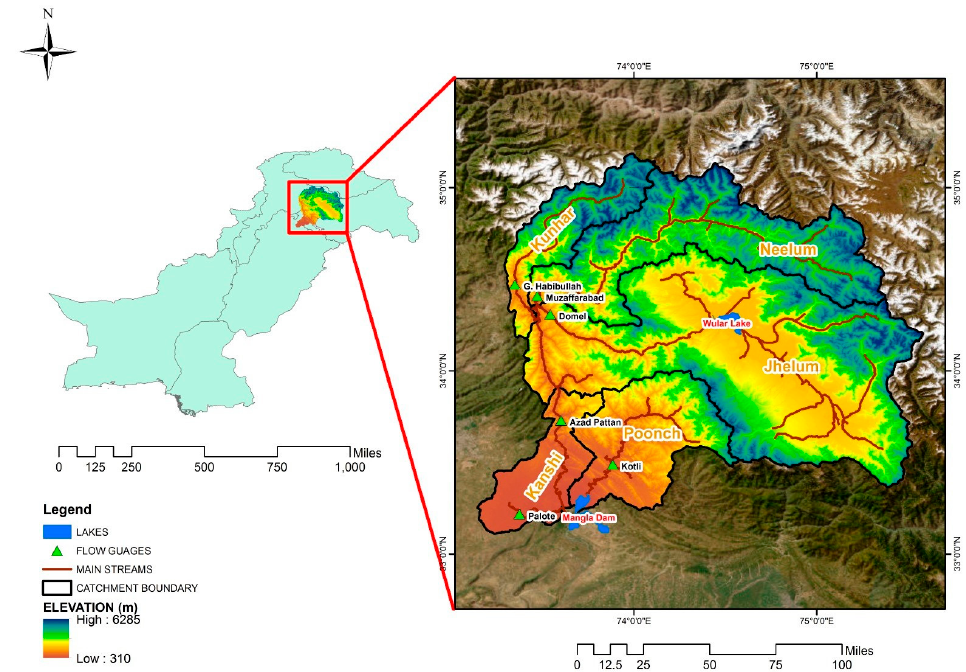
Figure 1. Study Area of Mangla Watershed.